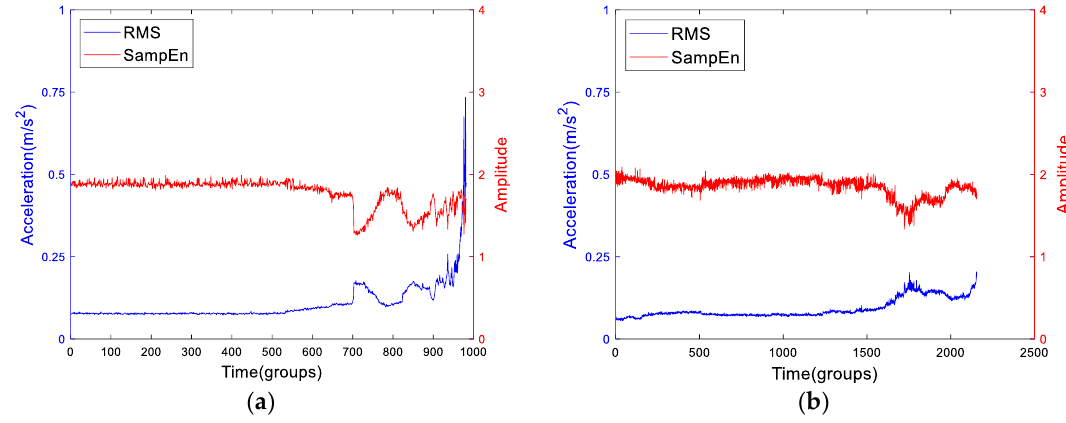
Figure 1. The root mean square (RMS) and SampEn curves of ( a ) Bearing2-1IMS and ( b ) Bearing1-4IMS.